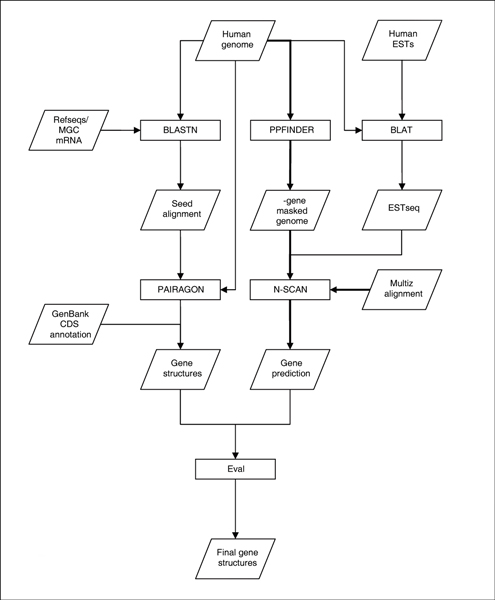
Block diagram of the Pairagon+N-SCAN_EST pipeline. The bold arrows mark the section of the flowchart corresponding to N-SCAN gene prediction.